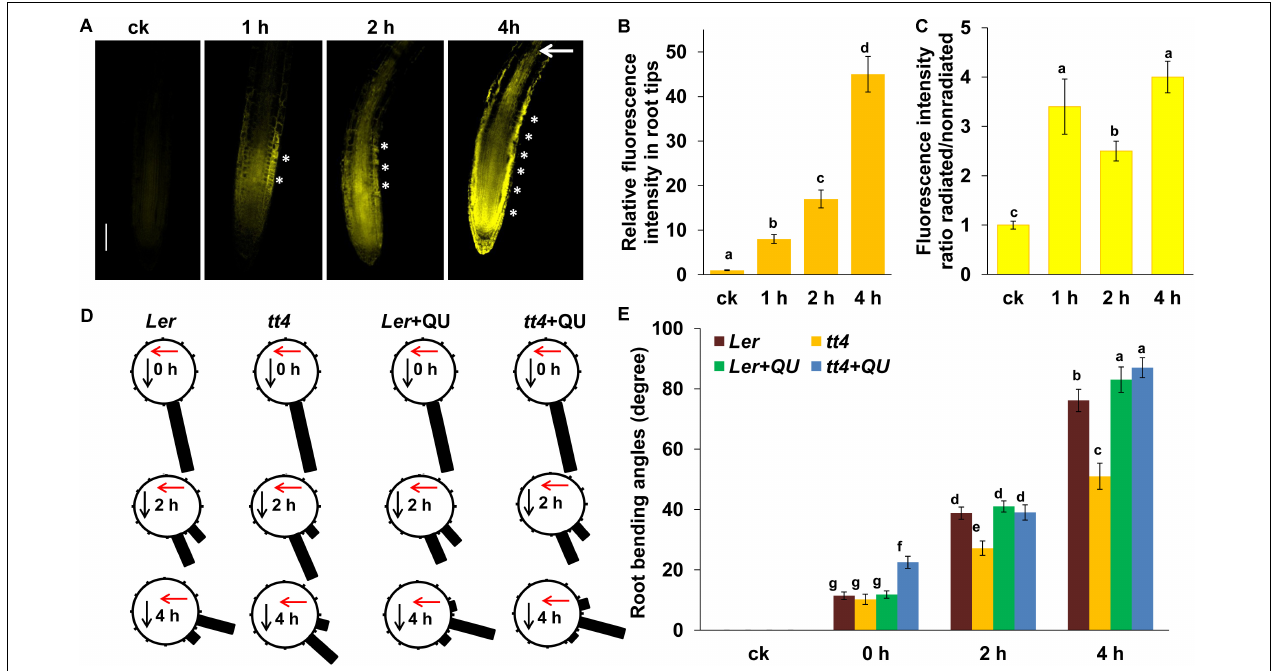
FIGURE 6 | Flavonoids are involved in UV-B-induced root bending. (A) DPBA fluorescence in the roots of 5-d-old wild-type Col-0 seedlings exposed to UV-B radiation for 1 h and then transferred to normal growth conditions for 1, 2, and 4 h. Bars, 100 µ m. (B,C) Quantification of DPBA fluorescence intensities in root tips (B) , and ratios of DPBA fluorescence intensities in the root tips on the radiated side versus the nonradiated side (C) are shown. (D,E) The angle of root bending of Ler and tt4-1 seedlings irradiated with UV-B for 1 h and then transferred to normal growth conditions plus 0 nM QU or 100 nM QU for 1–4 h, n = 60. (D) Each gravistimulated root was assigned to 1 of the 12 30 ◦ sectors on a gravitropism diagram. The length of each bar represents the mean percentage of seedlings assigned to the respective sector. The red and black arrows indicate the direction of UV-B radiation and gravity, respectively. (E) The average root bending angles of Ler and tt4-1 seedlings; ck, before UV-B radiation control. White asterisks indicate more pronounced DPBA fluorescence on the radiated side of roots. The error bars represent the ± SE, and different letters indicate significantly different values ( P < 0.01 by Tukey’s